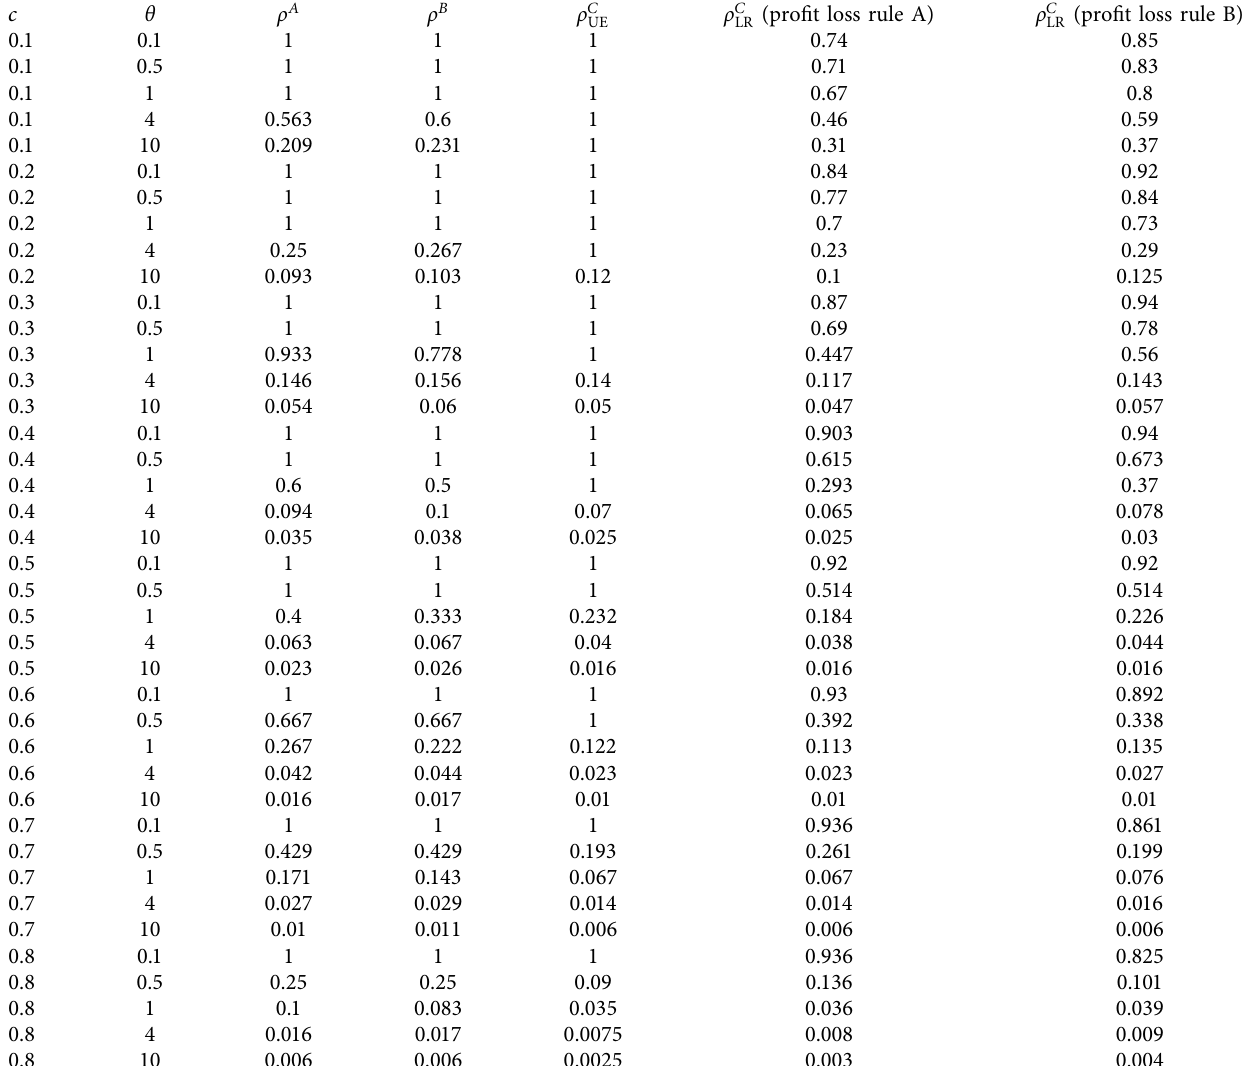
Table 3: Numerical examples of patent quality in different